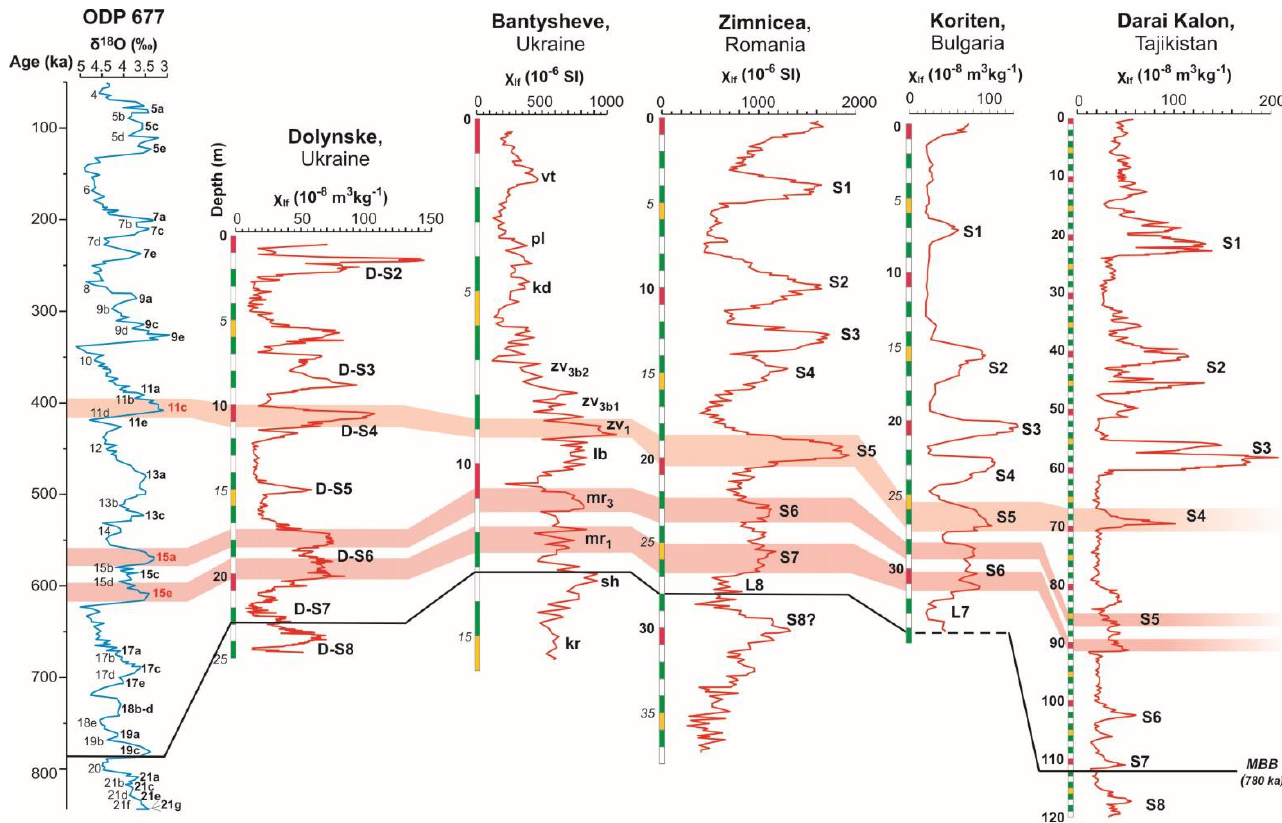
Figure 10. Correlation between marine isotope record from ODP site 677 [141] and selected loess – palaeosol sections from Ukraine [175], Lower Danube Basin [8,19] and Central Asia [78] resulting from magnetic susceptibility records and the positions of the Matuyama – Brunhes boundary (MBB).